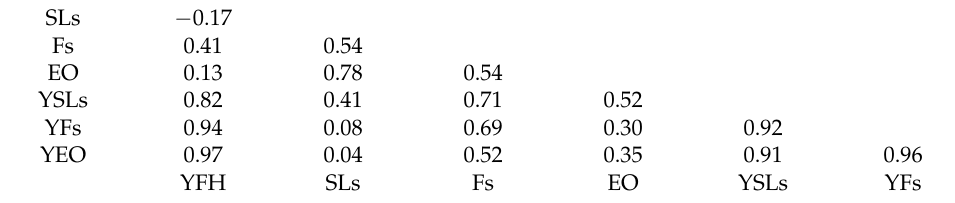
Table 5. Correlation coefficients for relationships between the studied traits of plants from the loamy soil during the three-year experiment ( n = 24); bolded correlation coefficients are statistically significant. For explanations, see Figure